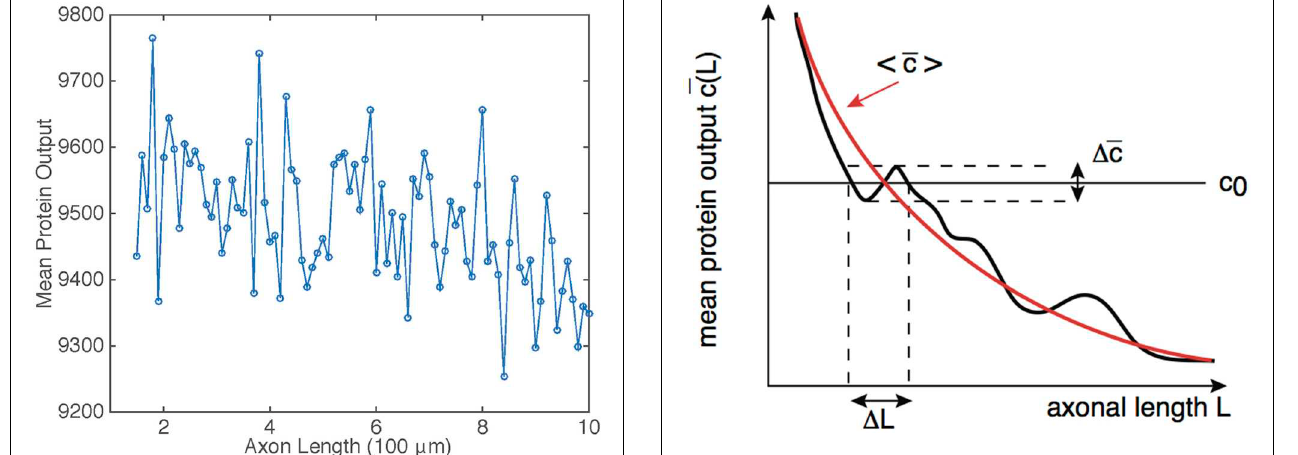
FIGURE 6 | Plot of mean protein output ¯ c vs. axonal length L . Results are based on simulations of the chemical master Equation (14) using the Gillespie algorithm with input s ( t ) h [ u I ( t ) ] . Parameter values used to generate = retrograde signal u I ( t ) are the same as in Figure 2 . Other parameter values are β 1 , µ 0 . 1 , λ 0 . 01 , and N 1000 . = = = =